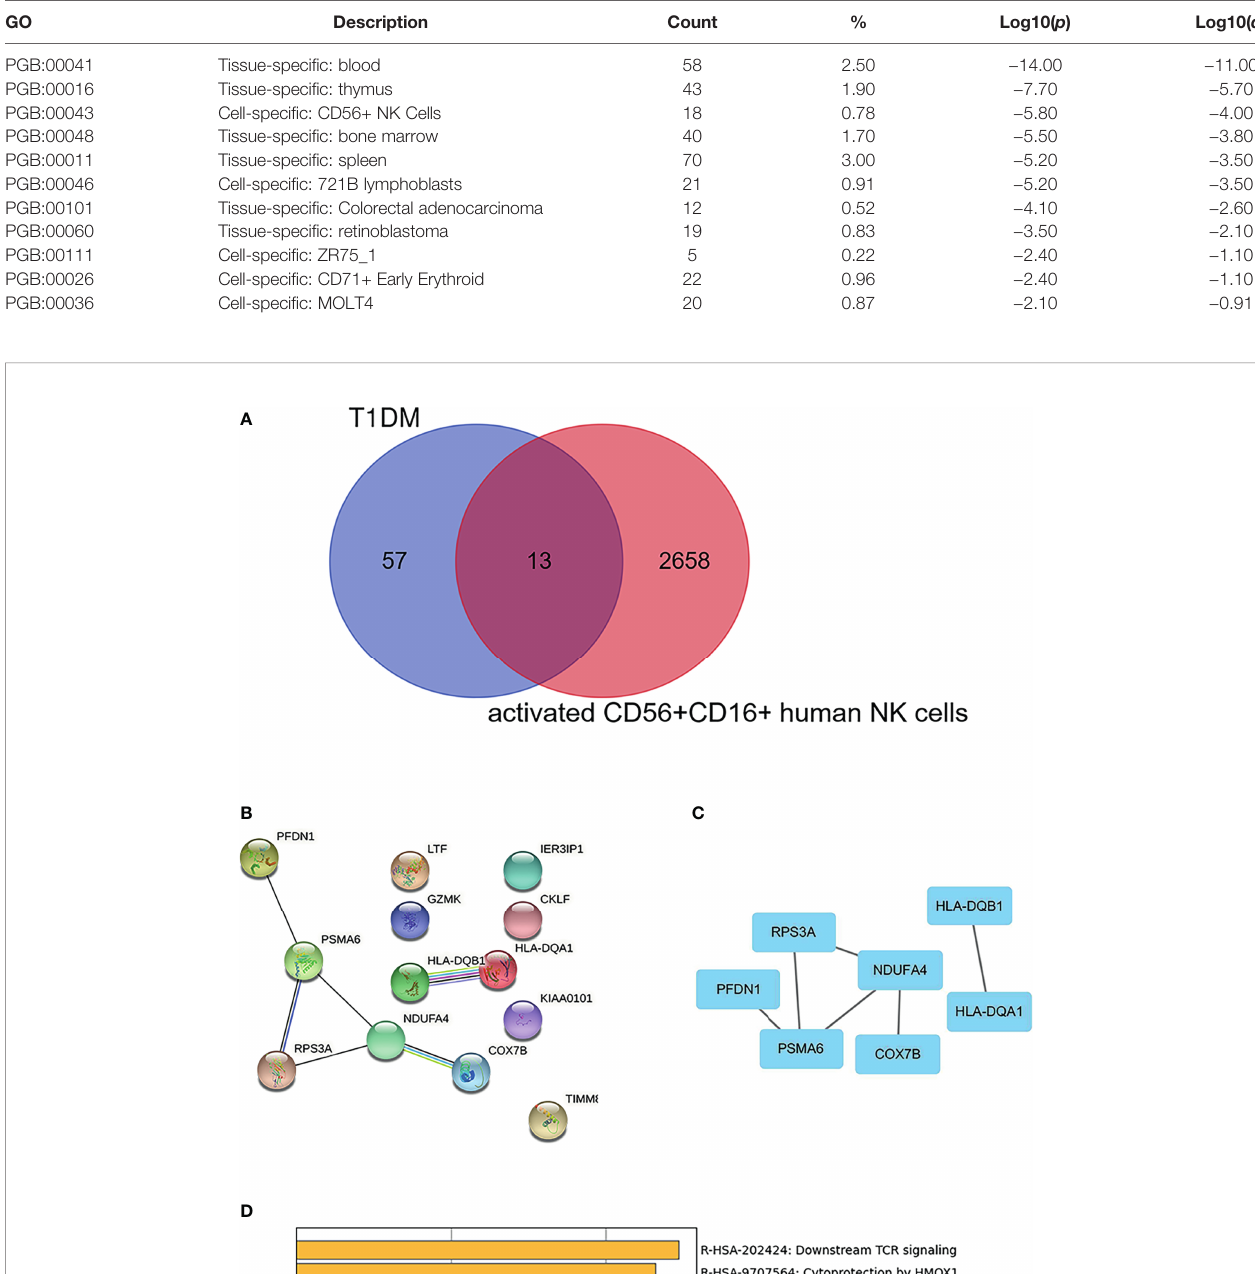
TABLE 2 | Summary of enrichment analysis in PaGenBase.